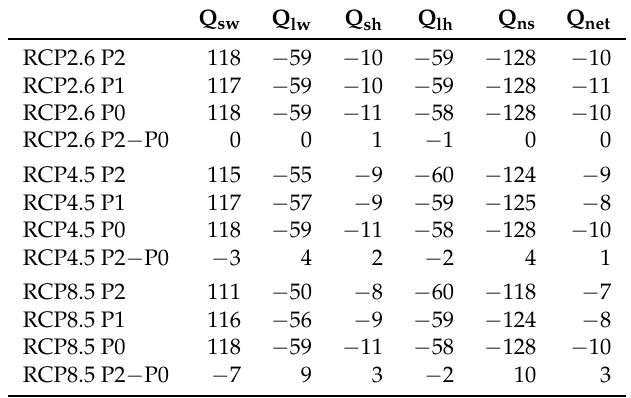
Table 4. Summary of climatological annual mean heat fluxes (W/m 2 ) during the three different climatological periods averaged over the North Sea for the ensemble mean of the RCA4-NEMO scenario experiments. The first three rows list the different heat flux components, respectively, and the last row lists the changes between periods P0 and